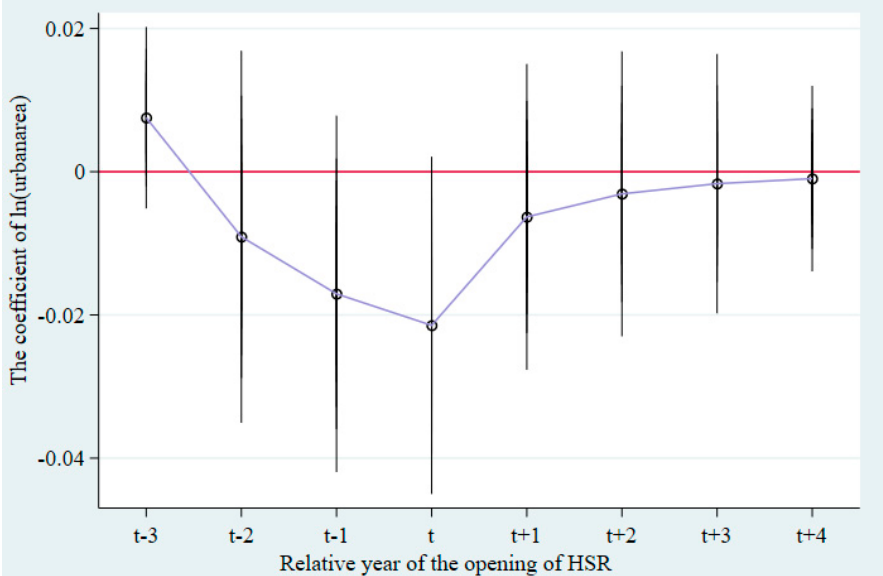
Figure 6. Parallel trend test.